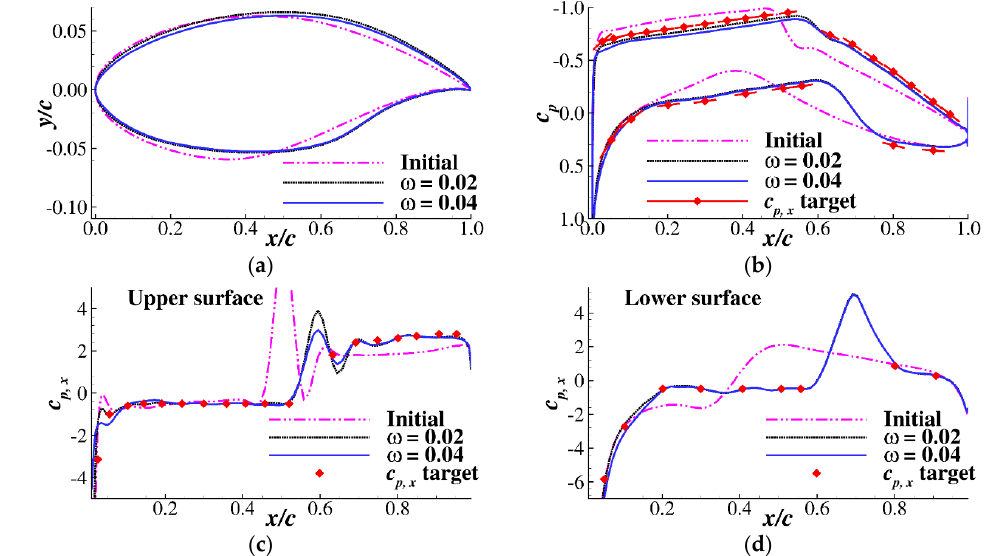
Figure 9. Airfoil, pressure and pressure gradient distributions of the supercritical NLF airfoil optimization. ( a ) Airfoil geometry; ( b ) pressure distribution; ( c ) pressure gradient of the upper surface; and ( d ) Pressure gradient of the lower surface.